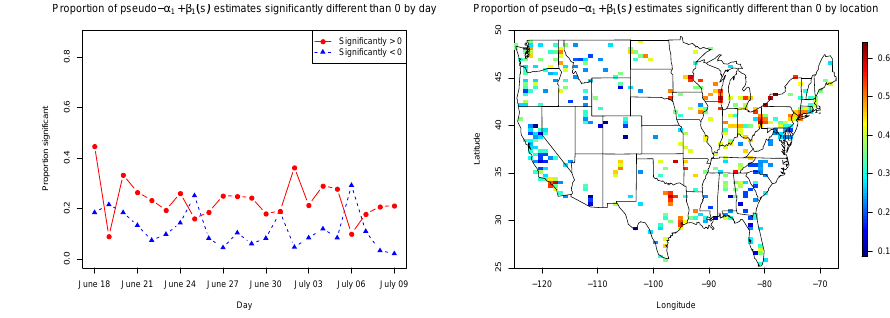
Figure 13. The proportion of pseudo-estimates by day (left) and across space (right) that are significantly different than 0.